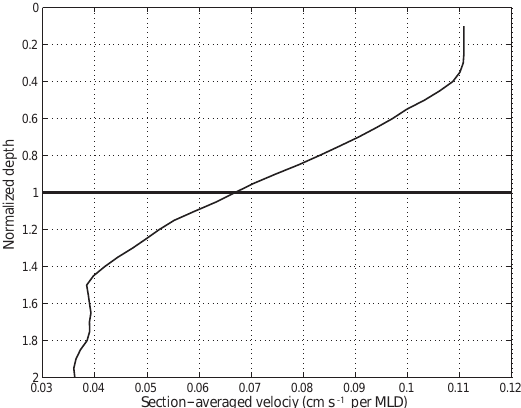
Figure 6. Section-averaged ageostrophic velocity at 14.5 ◦ N, nor- malized in depth by the local MLD. Velocity above 18m is set equal to the velocity at 18m. MLD is defined as the depth where the den- sity is 0.01kgm − 3 different from the value at